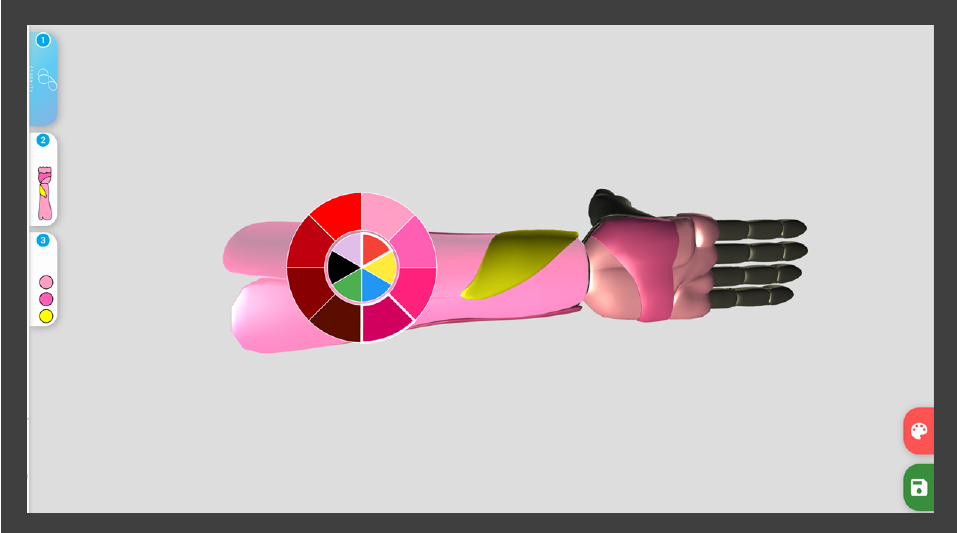
Figure 2. Developed customization web portal for selecting different 3D geometries and color palette selection, with full 3D visualization and